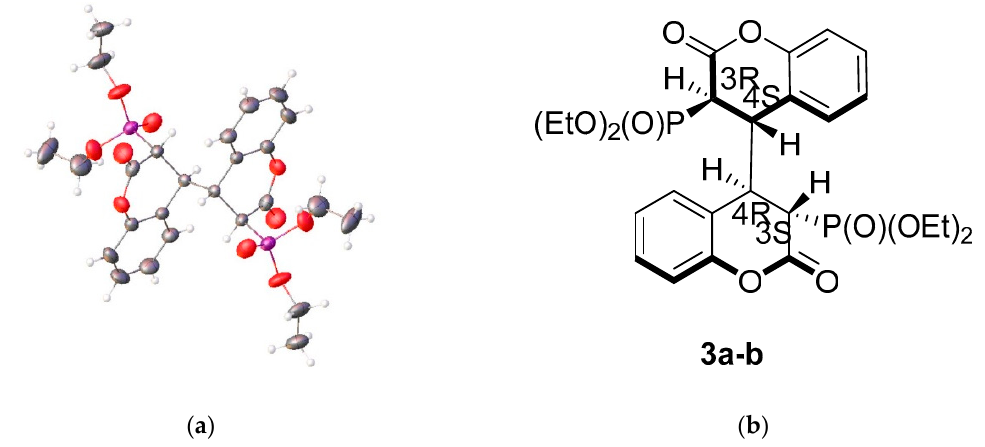
Figure 1. Structure of compound 3a : ( a ) ORTEP representation with thermal ellipsoids 40%—Crystal Data for C 26 H 32 O 10 P 2 ( M = 566.45 g/mol): monoclinic, space group P2 1 /n (no. 14), a = 12.3959(15) Å, b =